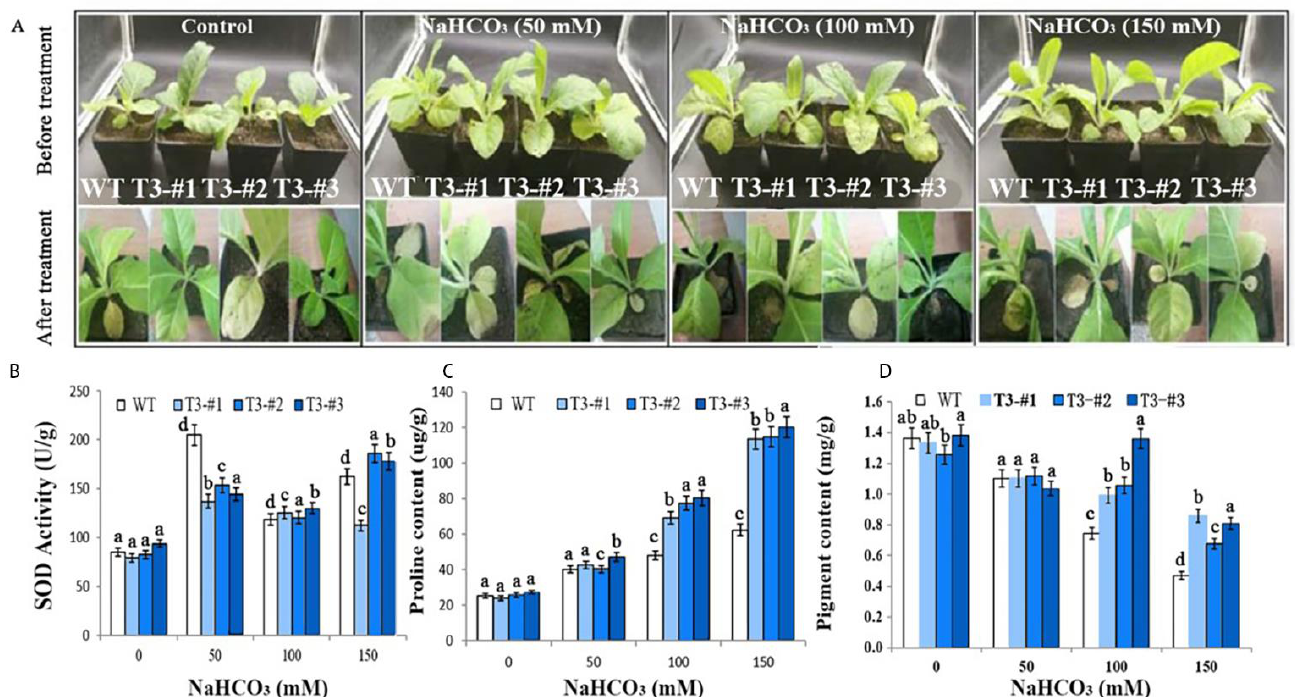
Figure 7. Enhanced alkaline tolerance in N. tabacum overexpressing AmPAL . ( A ) Plant phenotypes. The upper and lower panels indicated plants before and after treatment, respectively. One control and three NaHCO 3 treatment groups (50, 100, and 150 mM, respectively) were included. For each group, one WT and three transgenic plants (#1–3) were shown. ( B – D ): quantification of SOD, proline, and chlorophyll, respectively. Marking: The letters on the bar chart are marked for significance analysis. Where there is one same marking letter, the difference is not significant; where there is different marking letters, the difference is significant. The more different letters are, the more significant they are.